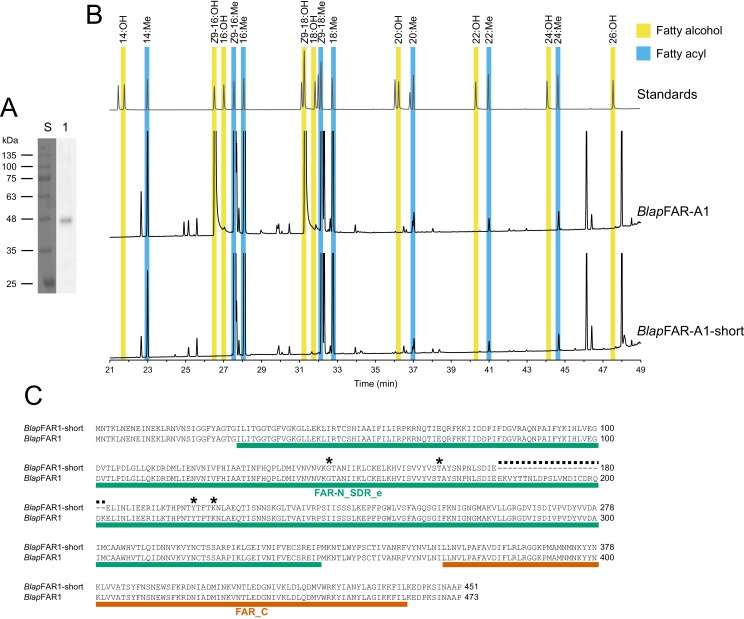
Protein expression and lipid profile in yeast expressing BlapFAR-A1-short.(A) Protein expression pattern determined in yeast cell lysate using western blot followed by detection with anti-6×His-tag antibody. Lanes: S, protein standard (VI, AppliChem); 1, yeast carrying plasmid with the sequence of BlapFAR-A1-short. (B) Chromatogram traces of lipid extracts from the yeast strains expressing BlapFAR-A1-short and BlapFAR-A1. (C) Protein sequence alignment of BlapFAR-A1-short and BlapFAR-A1. The 22-residue sequence lacking in BlapFAR-A1-short is indicated by a black dashed line above the sequence. The conserved domains FAR-N_SDR_e (accession number cd05236) and FAR_C (accession number cd09071) from Conserved Domain Database are underlined. The amino acid residues forming putative active site are marked with an asterisk.